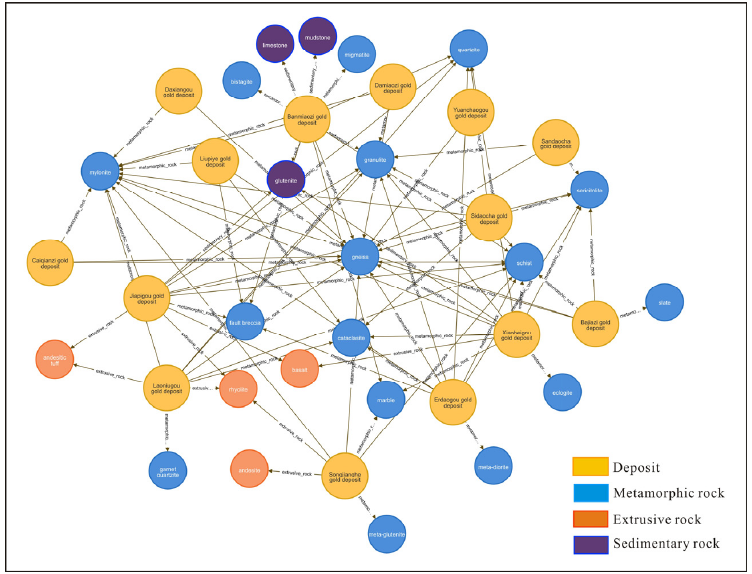
Figure 10. A subgraph for metamorphic rocks, extrusive rocks, sedimentary rocks, and ore deposits. Regional structures. The regional structure of the JGMB includes folds and faults, as shown in Figure 11. Among them, the fold structures are the Banmiaozi anticline, Hongqiling syncline, Bajiazi anticline, etc. The regional faults include the Huifahe and Ji’an-Songjiang faults. Among them, the Huifahe fault activity is the most intense. The distribution direction of Mesozoic and Cenozoic faulted basins, sedimentary formations, and late Yanshanian granites in the area are controlled by this fault [2].